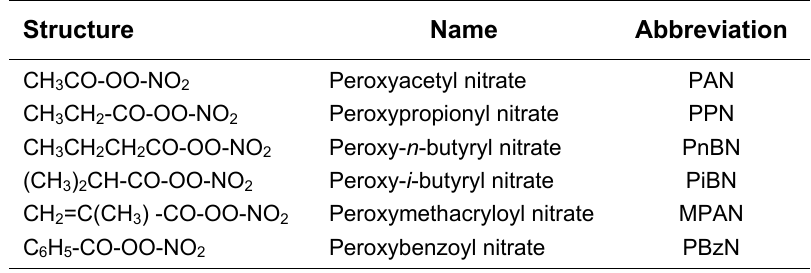
Chemical Structures of Peroxyacyl Nitrates (Peracylnitric Anhydrides)